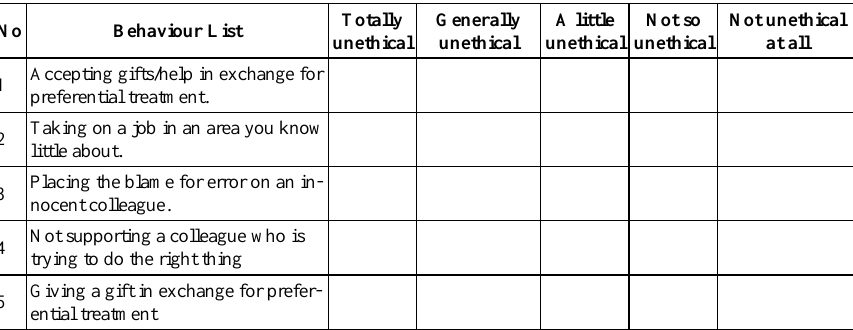
Table 2. Behaviour list and